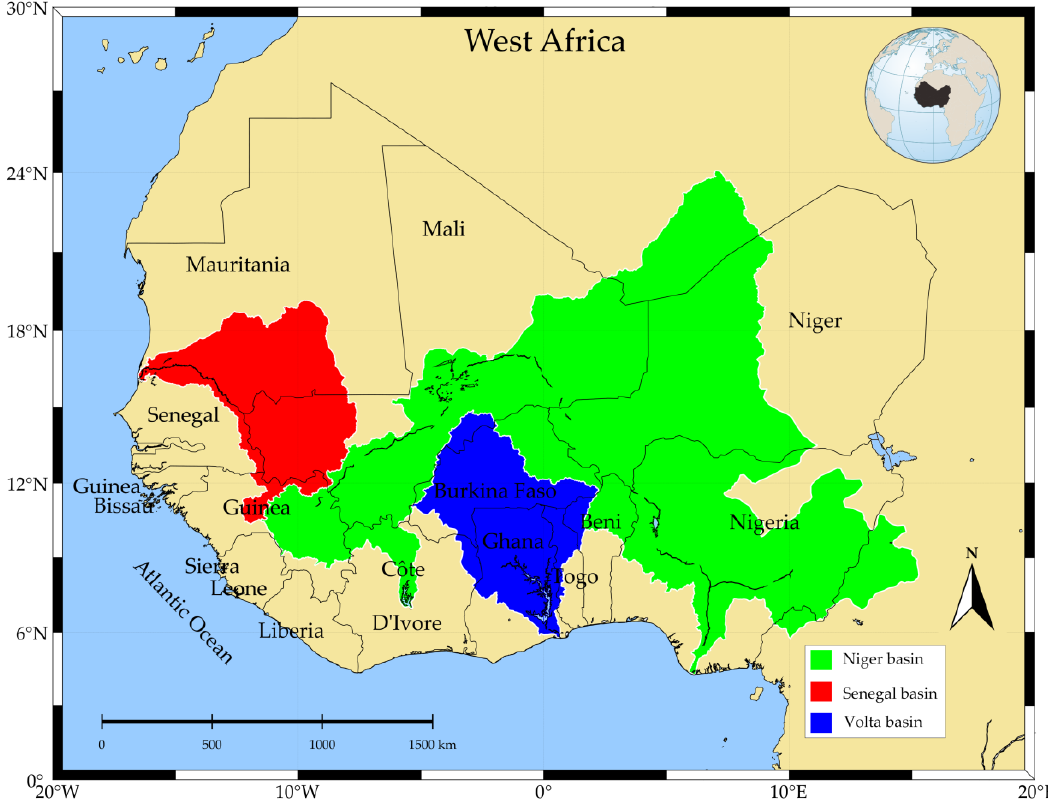
Figure 1. The study area of West Africa (WA) and its major river basins, namely, the Volta Basin, represented by the blue-shaded region, the Niger Basin, represented by the green-shaded region, and the Senegal Basin, represented by the red-shaded region. The graphical scale is related to the center of map using the Mercator projection.